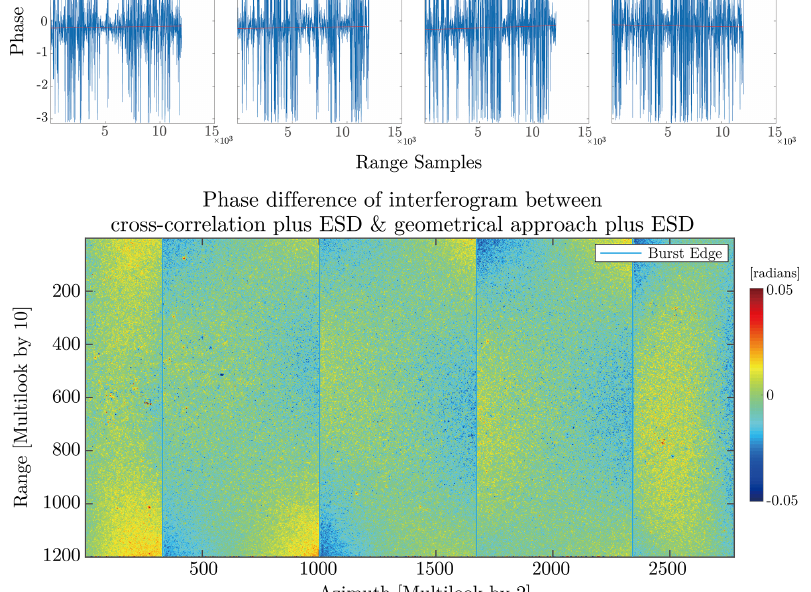
Figure 5. An example of Purdue University as the test site with 24 days baseline. ( First row ) the interferogram mutlilooked by 10 × 2 with no filter applied; ( Second row ) the cross-interferogram after applying the cross-correlation method; ( Third row ) the cross-interferogram after applying the geometrical method; ( Last row ) the difference of interferogram phase between the proposed approach and the established